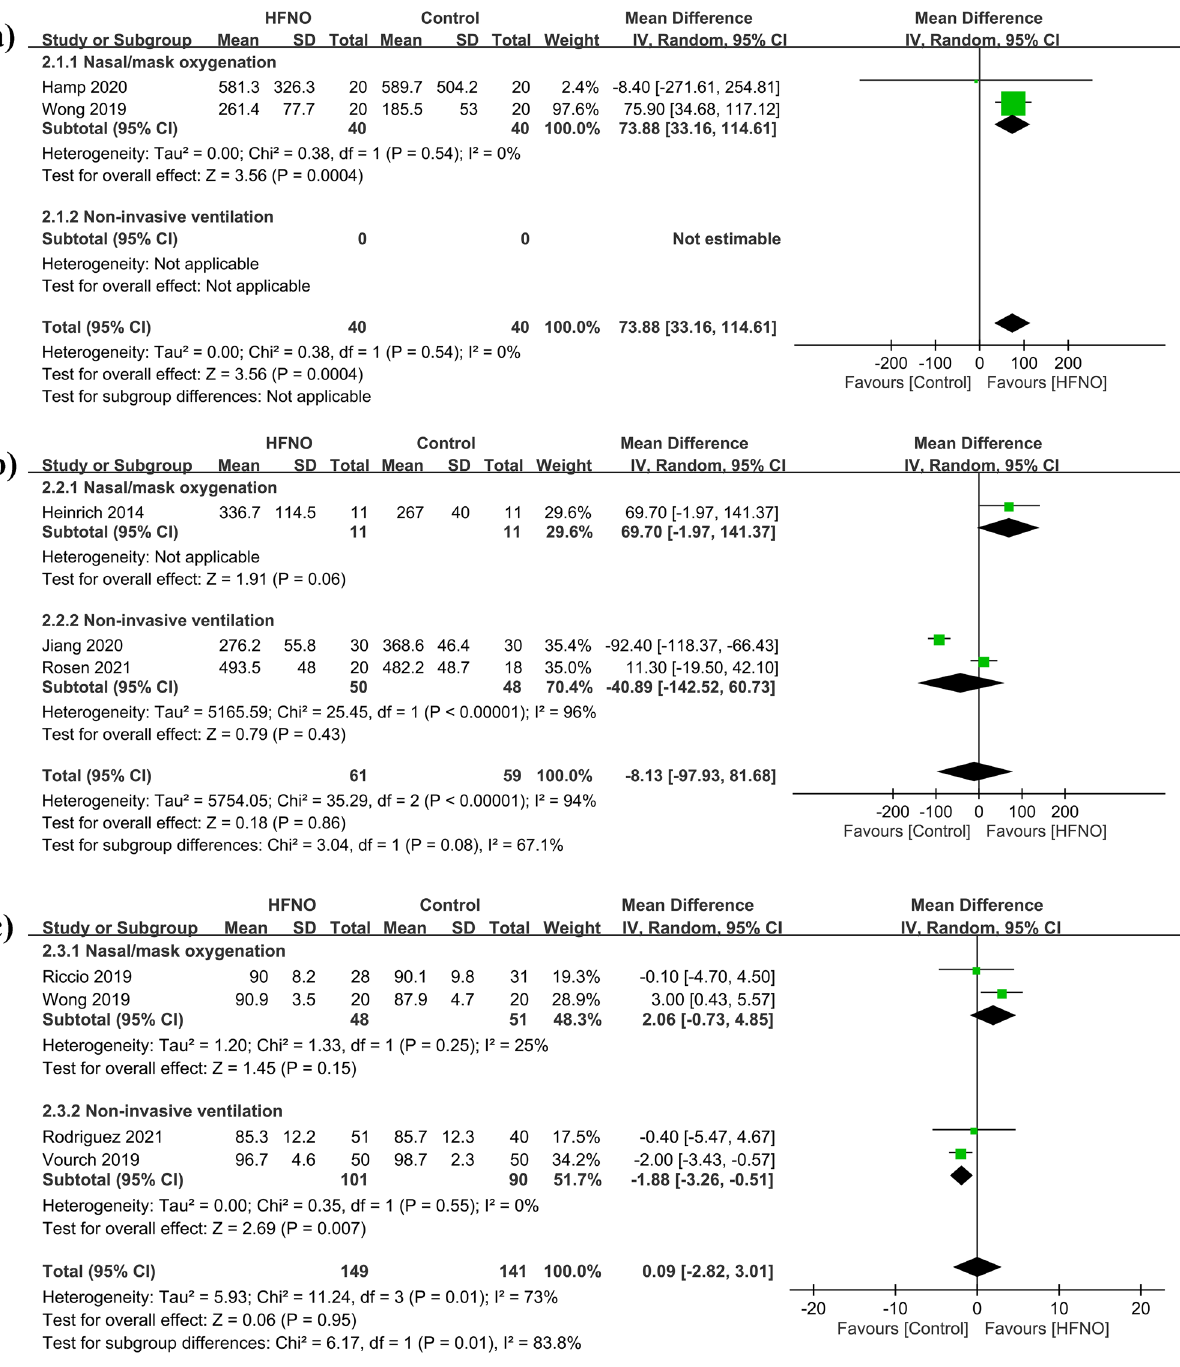
Figure 4. Forest plot comparing ( a ) safe apnea time, ( b ) PaO 2 , and ( c ) minimum SpO 2 between HFNO and control groups. HFNO, high-flow nasal oxygenation; IV, inverse variance; CI, confidence